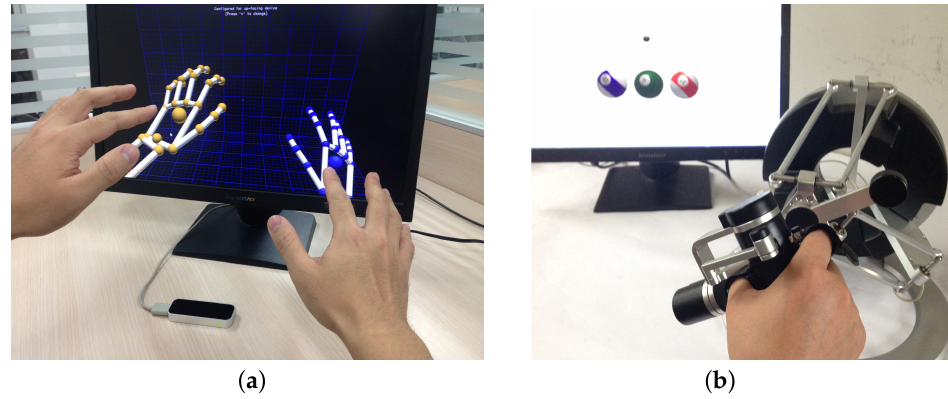
Figure 4. ( a ): the Leap Motion sensor tracks the motion of a healthy hand; ( b ): the omega.7 device assists the impaired hand with force